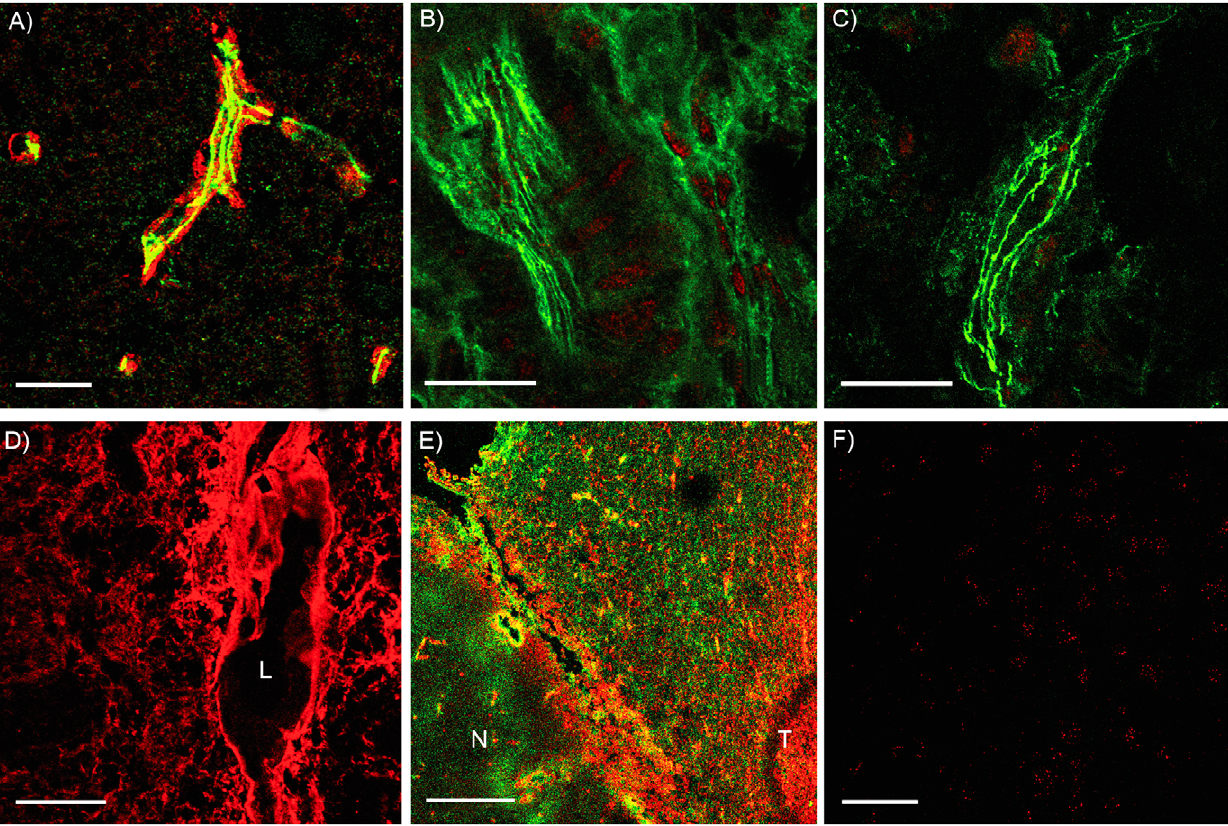
Figure 1. Immunoreactivity against AQP4. (A) Rat control brain, AQP4 (red) is restricted to astrocytic endfeet contacting the blood vessel (green ZO-1). (B) Extracranial implanted C6-tumor, no AQP4 could be detected, green ZO-1. (C) C6-tumor implanted into the flank, no AQP4 could be detected, green ZO-1. (D) Intracerebral implanted C6-tumor, immunofluorescence (red) shows an intensive staining for AQP4 (L: blood vessel lumen). (E) Right side: Intracerebral implanted RG-2-tumor (T); AQP4 (red) is present in astrocytes all over the tumor tissue and stronger fluorescence in the reactive astrocytes, compared to the healthy part of the brain (N), GFAP (green). Left side: healthy part of the brain (N), AQP4 (red) is restricted to astrocytic membranes contacting the blood vessels. (F) No AQP4 could be detected in C6 cell cultures. Scale bars each 20 m